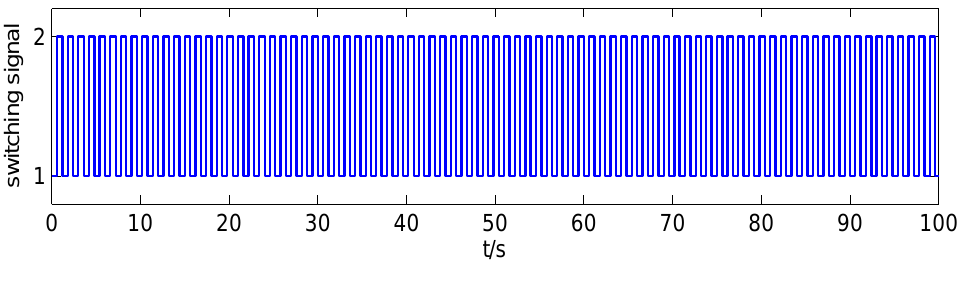
Figure 1. Switching signal with average dwell time (cid:28)